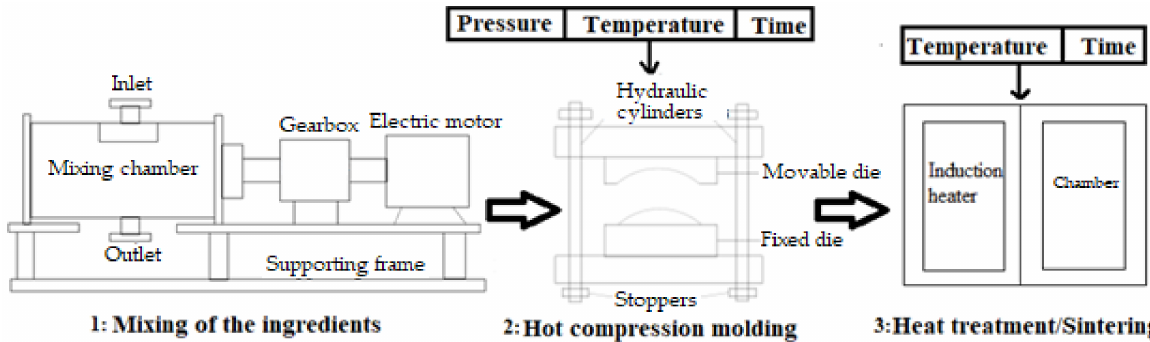
Figure 1. Manufacturing process of friction brake materials along with the corresponding input